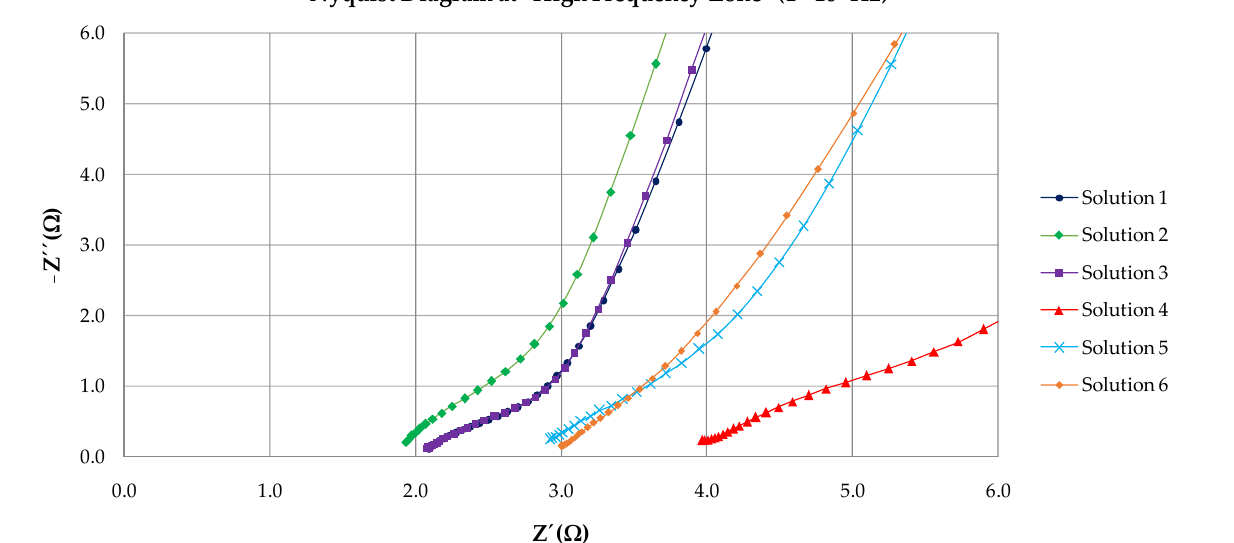
Figure 6. Nyquist diagram in “Low-Frequency Zone” (0.01 Hz).